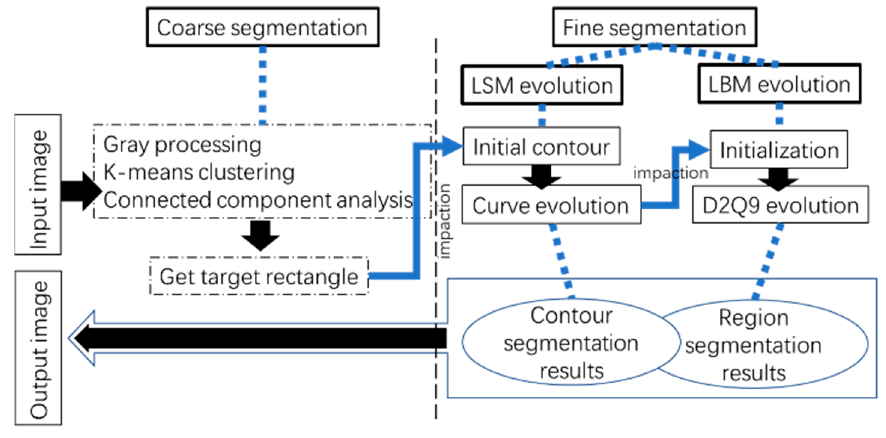
Figure 3. Flow diagram of framework.